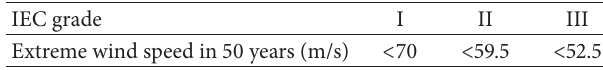
Table 7: Security grade of the wind farm.